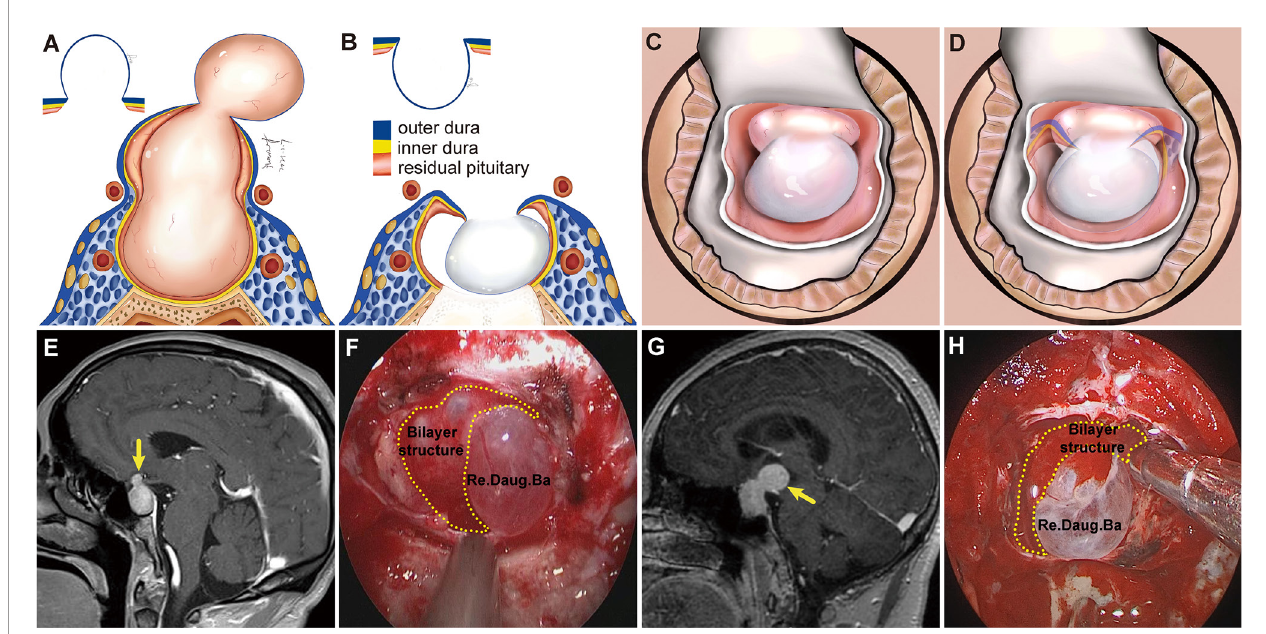
FIGURE 5 | Schemes, preoperative magnetic resonance images (MRI), and endoscopic views showing a daughter tumor and reverse daughter balloon. (A) Illustration of the formation of a daughter tumor. The thinning or even absence of the residual pituitary caused the bilayer to be weaker, leading to an inability to resist the intratumoral pressure. Thus, a daughter tumor formed, like a thinning tire creating a bulge. (B, C) Illustration of reverse daughter balloon. When the tumor was completely removed, due to the intracranial cerebrospinal fl uid pressure, the thin dura on the surface of the daughter tumor inversely protruded into the tumor cavity, forming a reverse daughter balloon. Diagram (D) is a merge of diagrams (B, C) . (E, G) Preoperative, sagittal post-gadolinium MRI showing grade 1b tumor with a small daughter tumor extending into the suprasellar space. (F, H) Endoscopic view after tumor resection showing a reverse daughter balloon. Re. Daug. Ba, reverse daughter